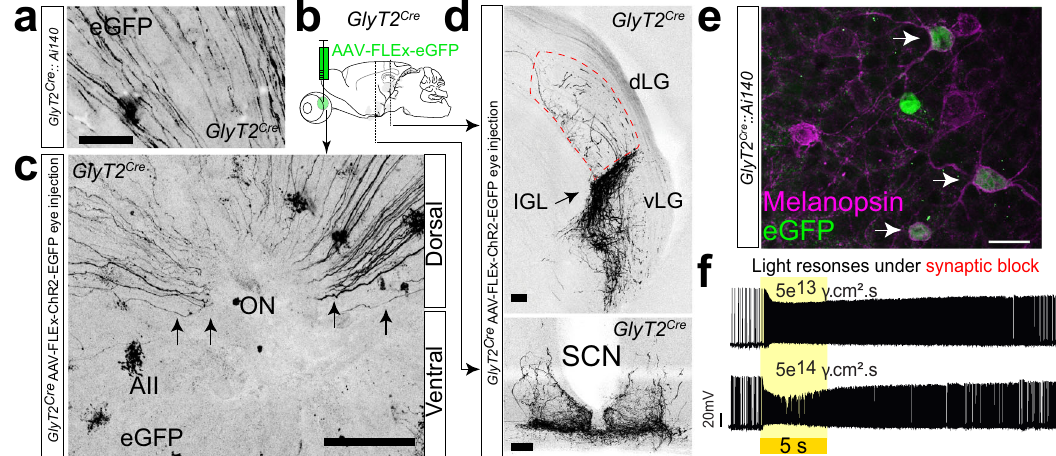
Fig.1|AsubpopulationofipRGCsinthedorsalretina.a RGCaxonsidenti fi edin the dorsal portion of GlyT2 Cre ;Ai140 whole-mount retina. b , c Cre-dependent virus injection into the eyes of GlyT2 Cre mice labels RGC axons that project from the dorsal retina via the optic nerve (ON) to non-image-forming central areas. d Intergeniculate lea fl et (IGL; top) and suprachiasmatic nucleus (SCN; bottom; dLGN and vLGN dorsal and ventral lateral geniculate nucleus . e Confocal